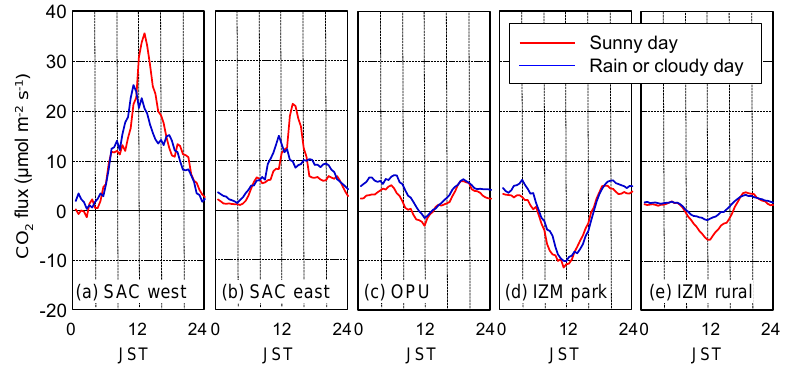
Figure A2. Mean diurnal variations in CO 2 fluxes at (a) SAC west, (b) SAC east, (c) OPU, (d) the urban park in IZM, and (e) the rural area in IZM during the period from April to September. The data are shown as the 1.5h running means. Sunny days were defined as days when the precipitation was less than 5mmd − 1 and the daily sum of solar radiation was greater than 80% of that expected from solar geometry.